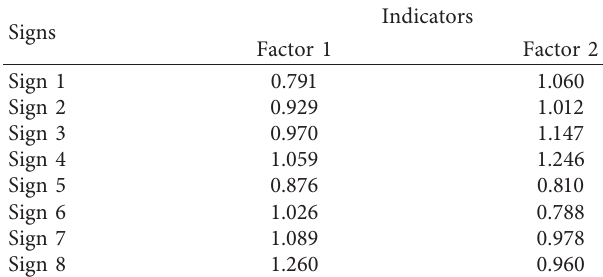
Table 10: Matrix Z .